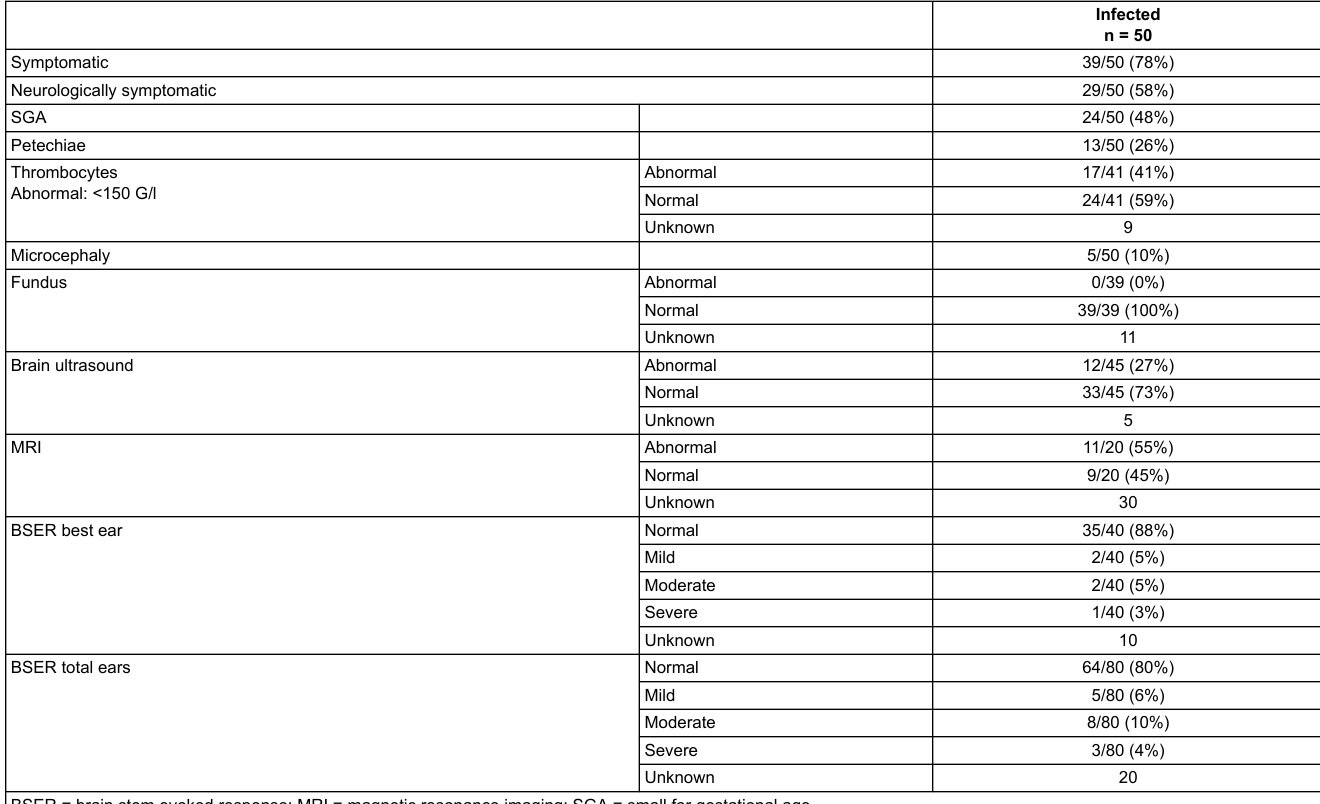
Table S1: Clinical outcomes at birth of all newborns with congenital cytomegalovirus infection.